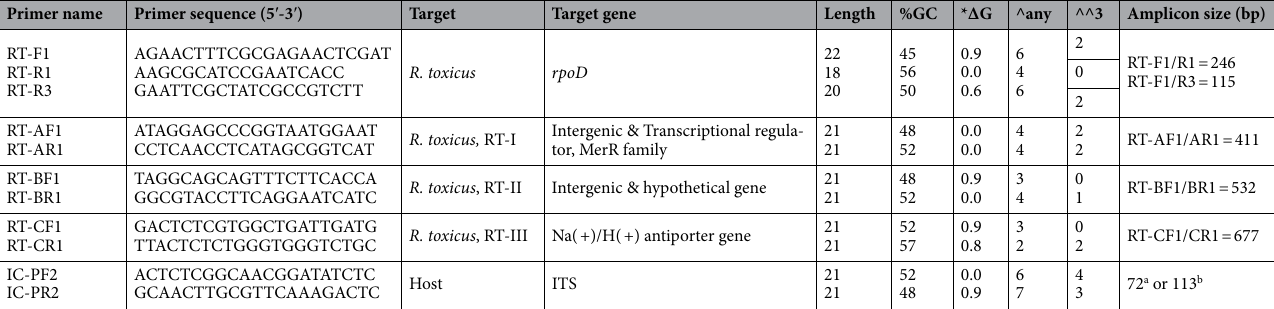
Table 2. Characteristics of primers used to differentially detect three Rathayibacter toxicus populations, host Lolium rigidum (host internal control) and plasmid DNA (internal controls). *Plot ΔG value in kcal/mol calculated by mFOLD; ^max self-complementarity; ^^max 3 ′ self-complementarity; rpoD —RNA polymerase sigma factor rpoD; RT-I, RT-II & RT-III are R. toxicus populations; a amplified a 72 bp fragment when used with artificial internal control AIC-2 contains targets for primer IC-PF2, IC-PR2; (c) b amplified a 113 bp fragment when used with host DNA (host internal control –